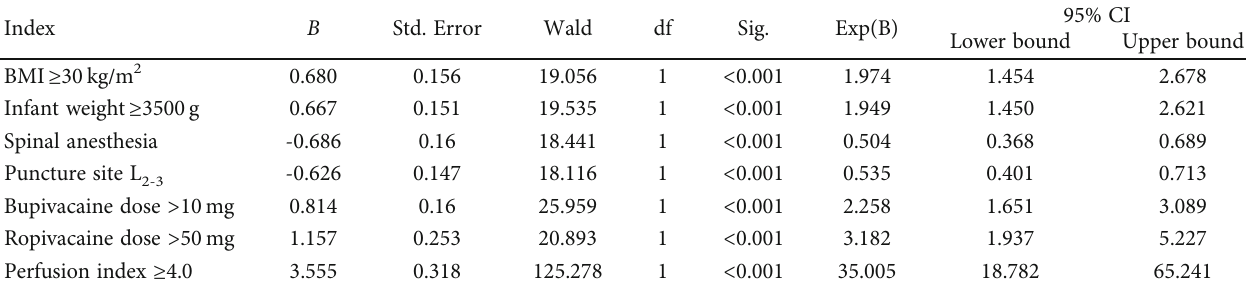
Table 3: Multivariate logistic regression analysis of risk factors for hypotension during cesarean